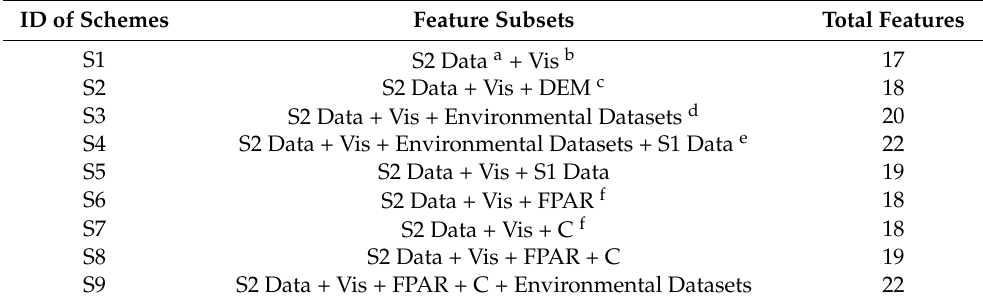
Table 1. The feature subsets of various